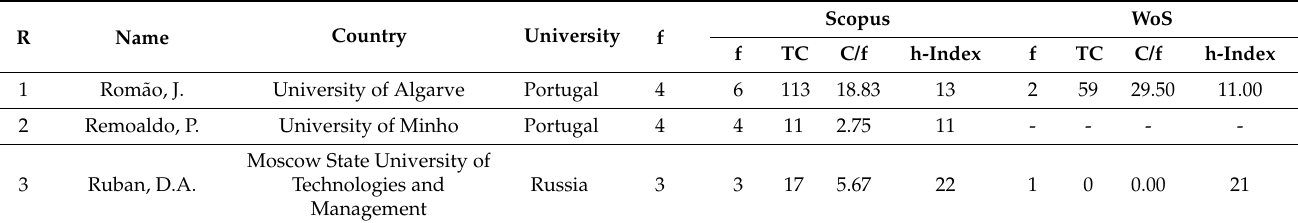
Table 6. Ranking of the most productive